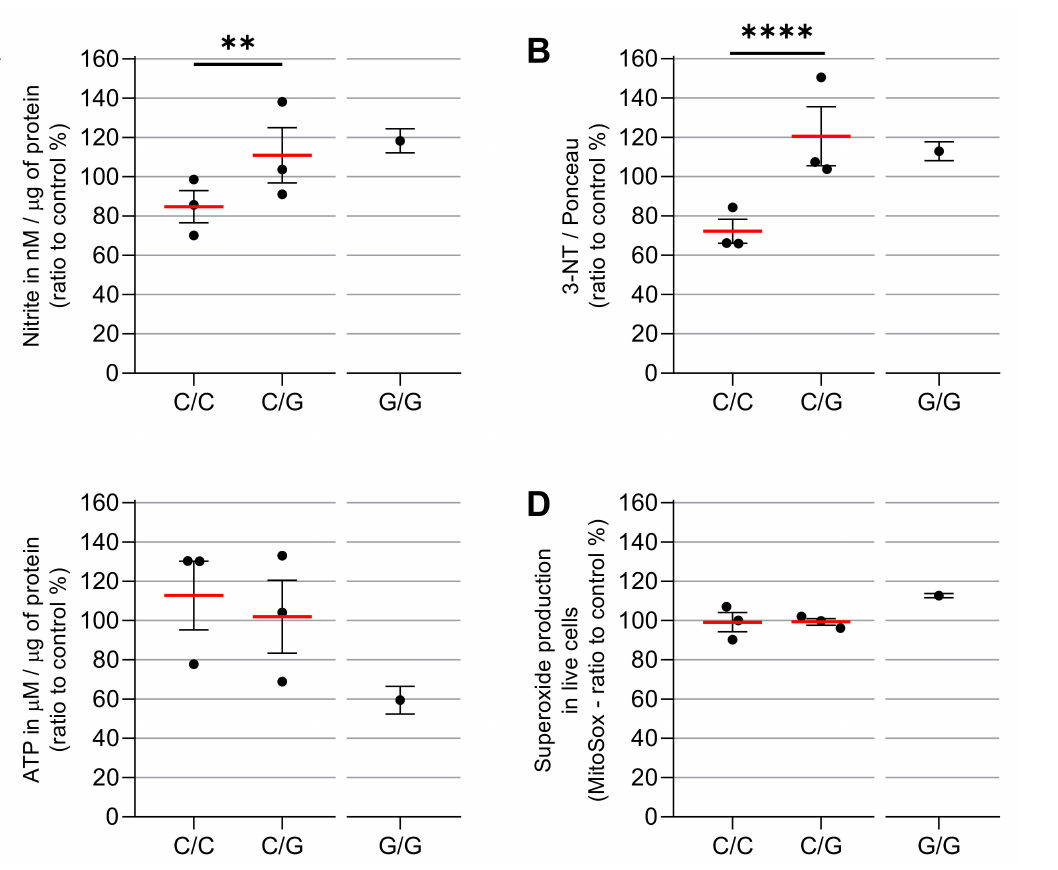
Figure 3. ATP production and nitro-oxidative stress after IFN- γ treatment in carriers or non-carriers of MRPS18B c.688 C > G MRPS18B p. P230A mitochondrial gene mutation. EBV-LCL were obtained from the PBMCs of the patients and infected with EBV for transformation. The EBV-LCL from the patients were stimulated in vitro with IFN- γ . We measured the production of nitrite ( A ), carried out relative quantification of nitrated proteins ( B ), ATP ( C ) and mtROS ( D ), after the stimulation with IFN- γ 25 ng/mL with MitoSOX™ Red, Griess Reagent Kit, Dot Blot, ATP Determination Kit and the anti-3-nitrotyrosine antibody. We here depict the average ratio between IFN- γ -treated vs. unstimulated cells. Each dot is a patient with ≥ 6 independent measurements. Experiments were repeated several times independently. As we had only one CME patient G/G, statistics were carried out only between C/C patients and C/G patients. Two-way ANOVA statistics were performed between C/C and C/G. ** = p < 0.01, **** = p <